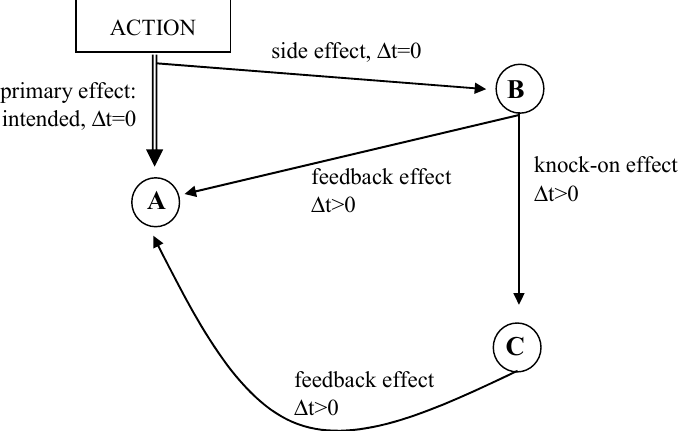
Figure 5. Side, feedback and knock-on effects. Source own, based on [6].